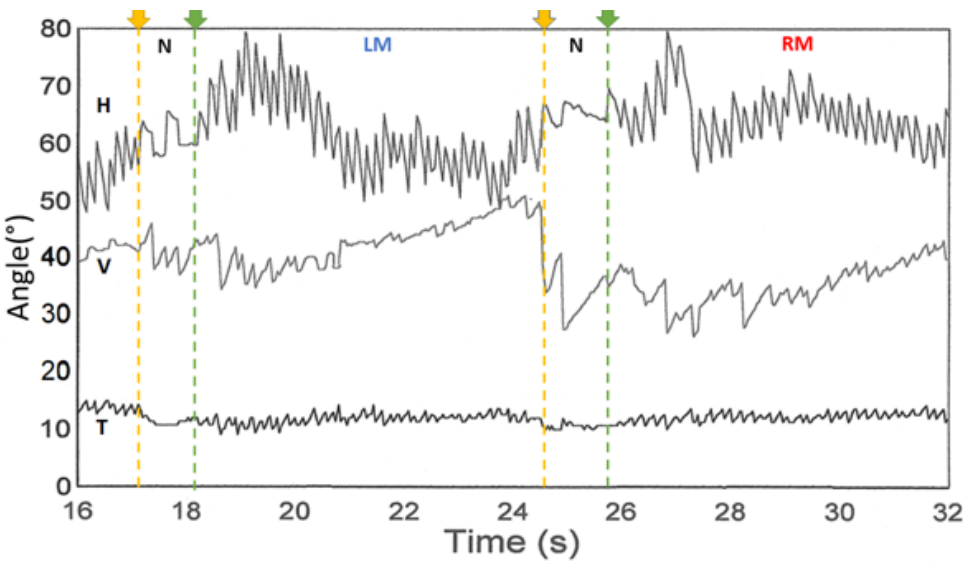
Figure 1. Three-dimensional recording of a positive test (BCV) (left severe unilateral vestibular lesion) from Dumas and Michel. Valeur sémeiologique du test de vibration osseux crânien. In: IPSEN, editor. XXXIème Symposium International d’Otoneurologie, Liège, Belgium (1997). The three components are observed H: Horizontal, V: Vertical, and T: Torsional. N: no stimulation; LM: Left mastoid stimulation; and RM: Right mastoid stimulation (VNG 3D recording device MFR-TOR3.4, Synapsys, Marseille,